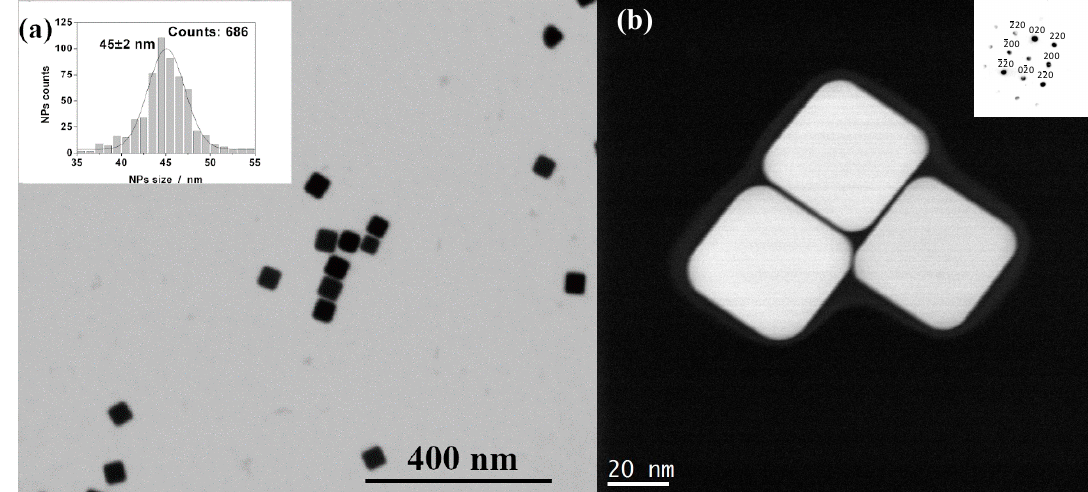
Figure 4. Scanning transmission electron microscopy (STEM) image of cubic silver nanoparticles